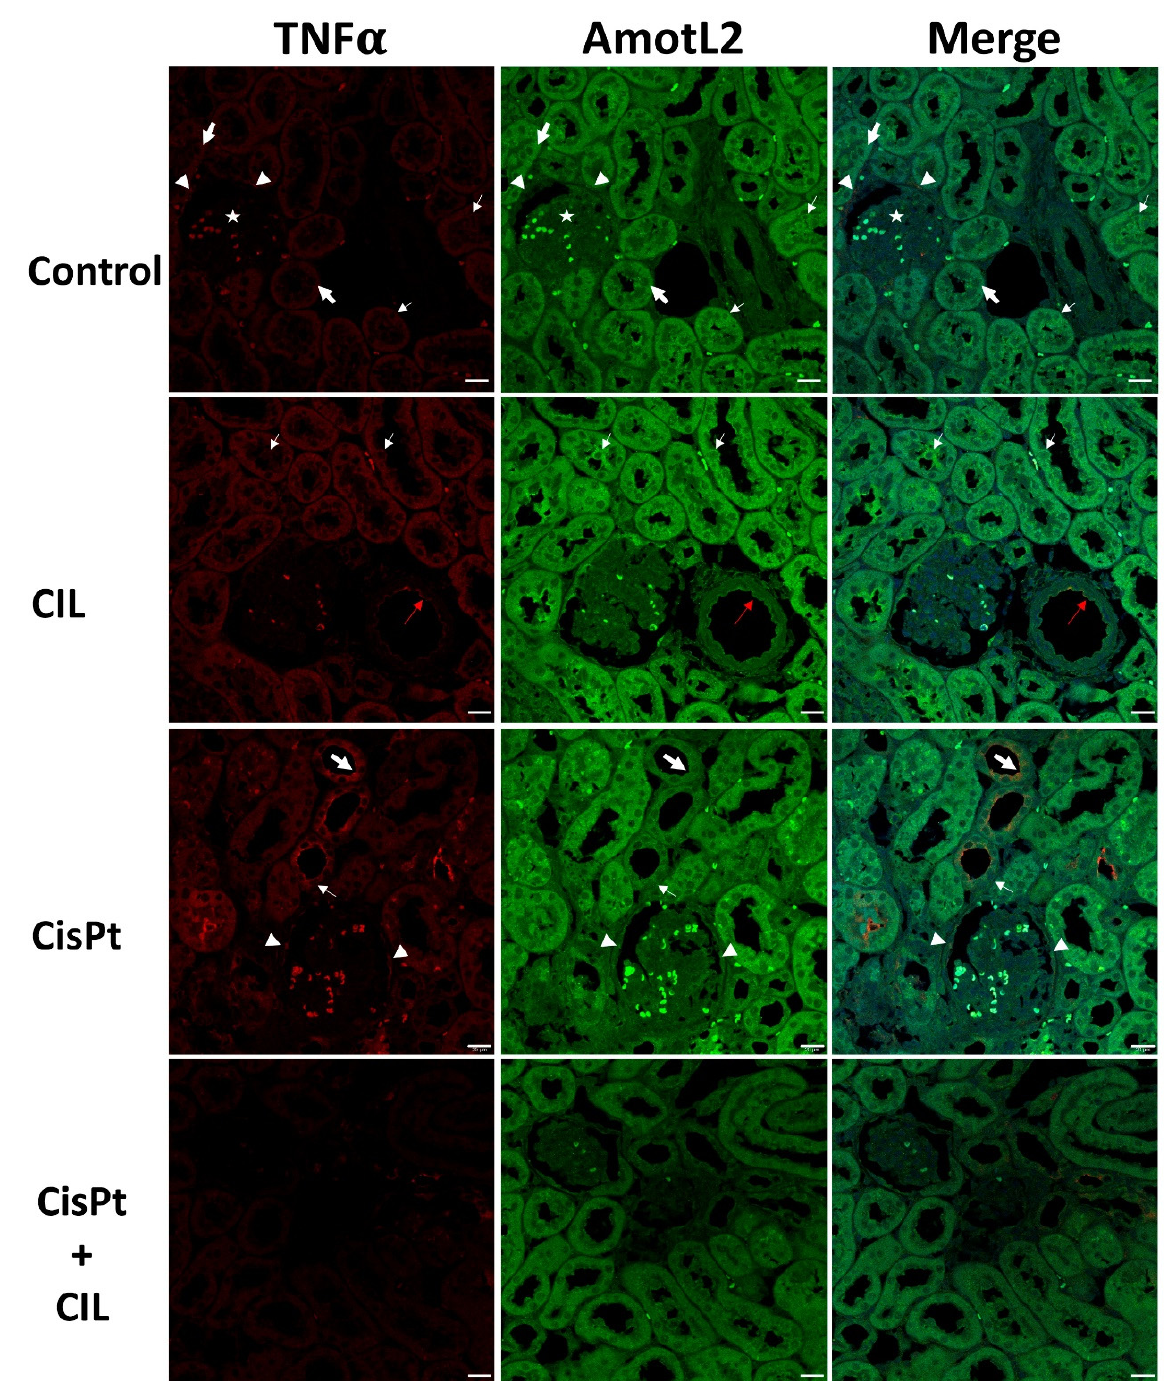
Figure 5. Expression of AmotL2 in the cisplatin-treated and cilastatin protected rat kidney. Control panels: tubular cells show low TNF α and homogeneous medium-intensity AmotL2 in cytosol (bold white arrows), most prominent in some cells around nuclei (thin white arrows). Some cells of the outer glomerular capsule show high staining intensity for TNF α and AmotL2 (white arrowheads). Glomerular cells show no TNF α signal and low AmotL2 staining (star). CIL panels: tubular cells of cilastatin-treated rats show homogeneous TNF α and AmotL2, with similar localization to controls, but at a slightly but definitely increased intensity level. AmotL2 staining is more intense around the nuclei of some cells, and most nuclei show AmotL2 staining in a dot-like pattern. Red arrows point to TNF α and AmotL2 immunostaining in the luminal side of endothelial cells of medium-sized